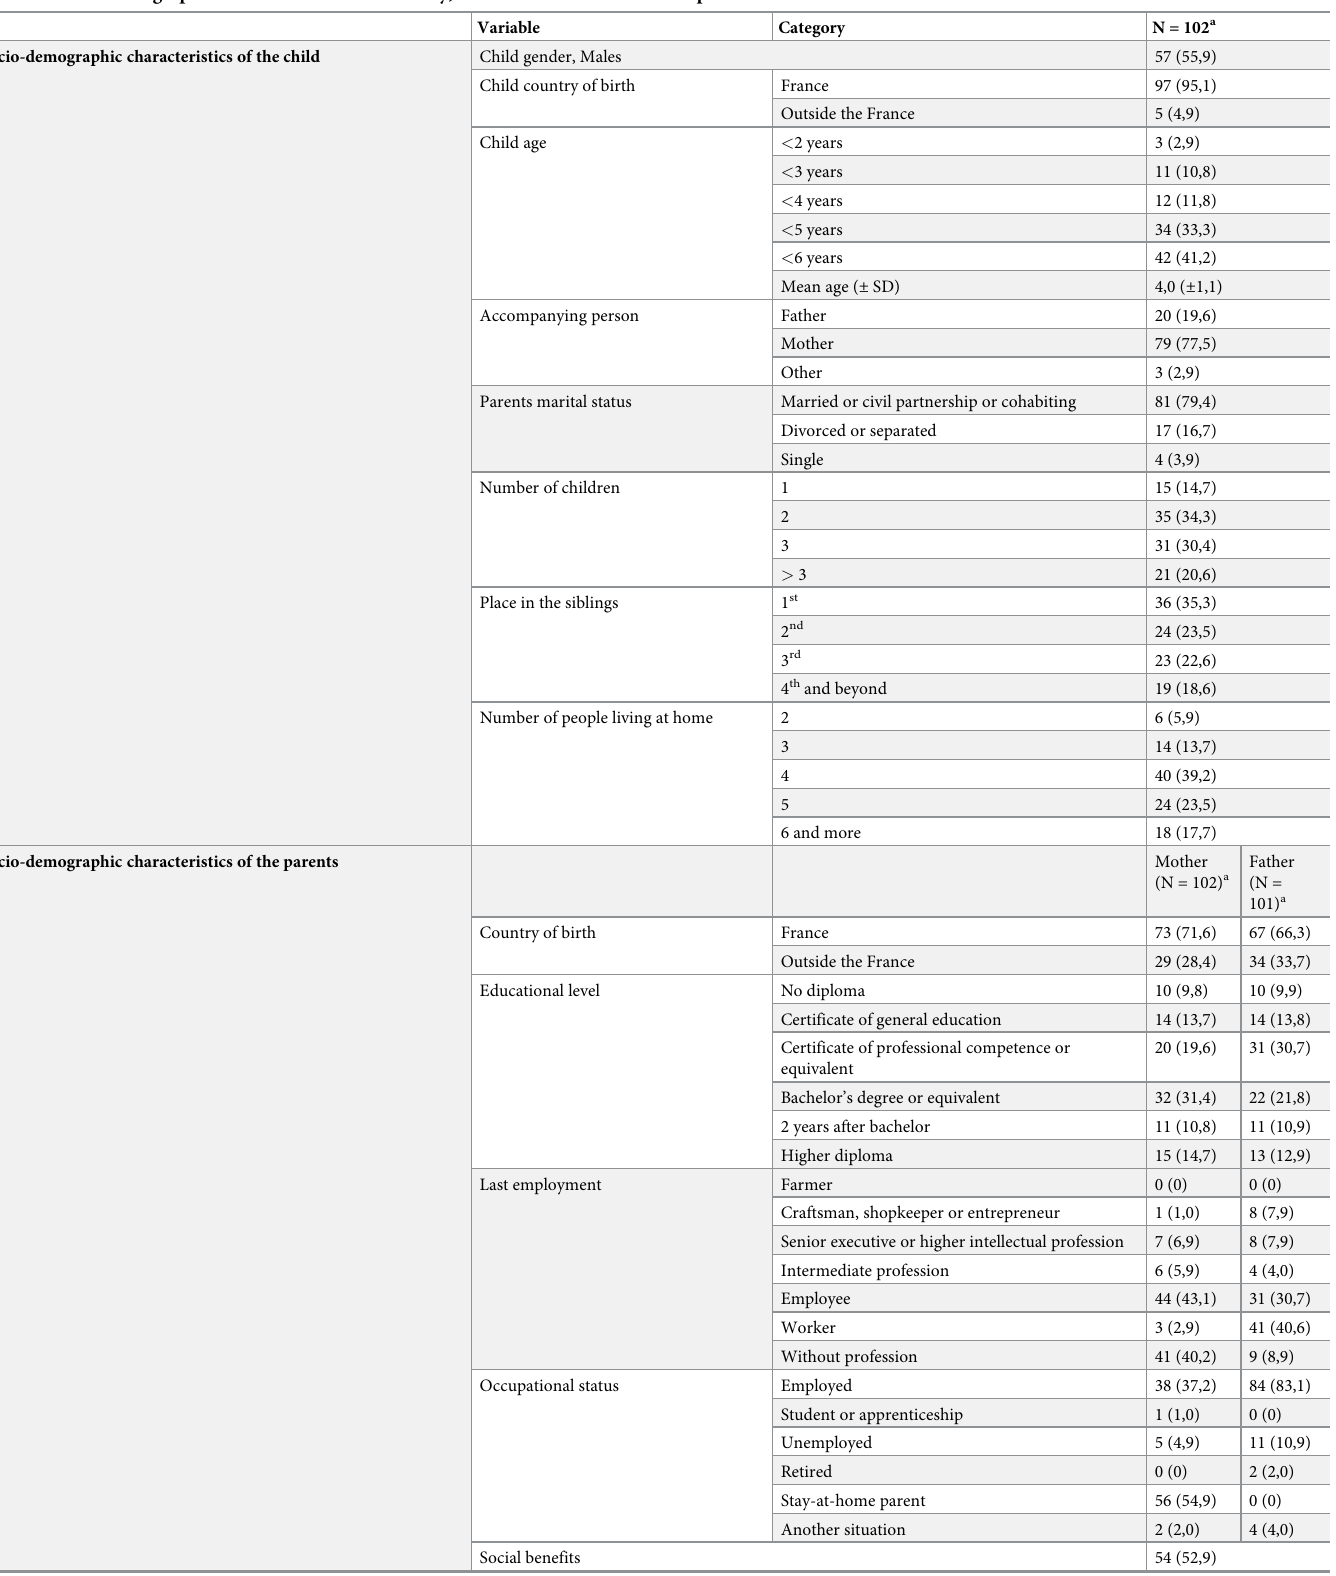
Table 1. Socio-demographic characteristics of the family, health status and oral health practices of the